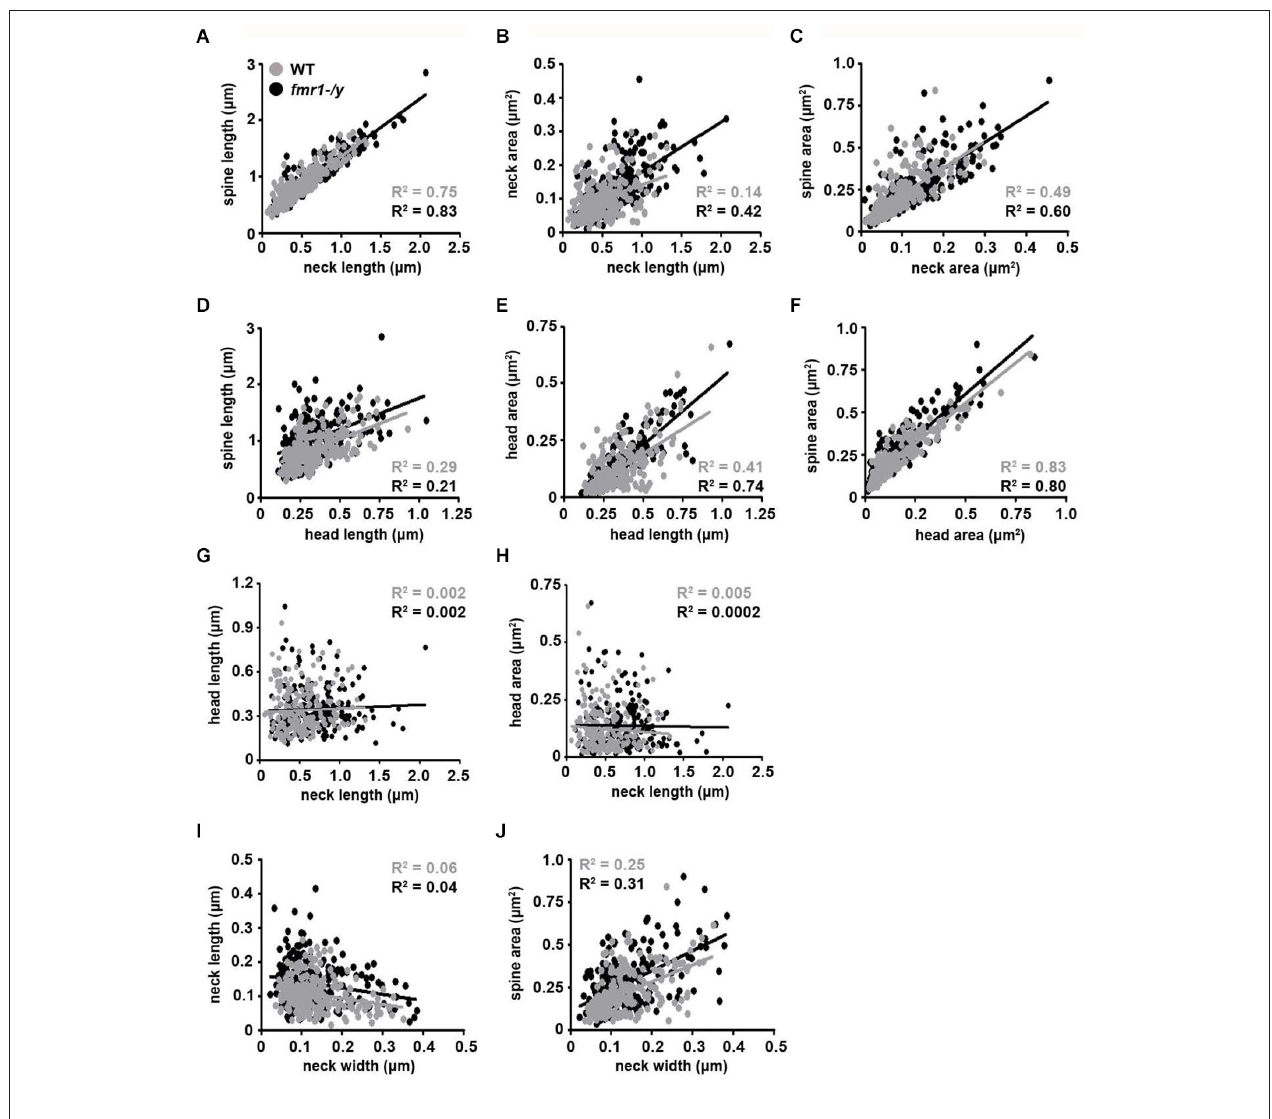
lines are black. Data points from fmr1-/y mice are highlighted in gray dots and best-fit trend lines are gray ( n = 221 wild-type spines, n = 224 fmr1-/y spines) . All Pearson R 2 values are color-coded as